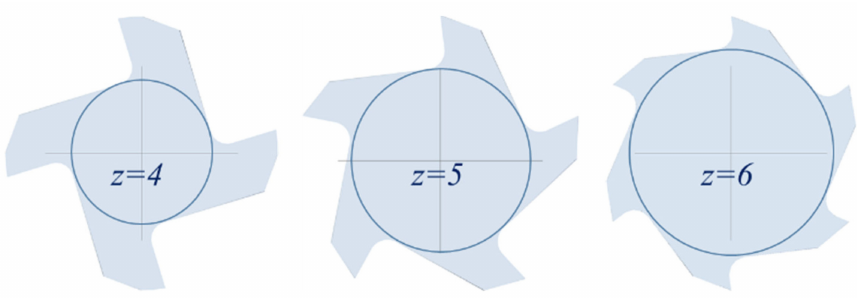
Figure 3. For the same tool diameter, with more teeth, there is a tool core increase.